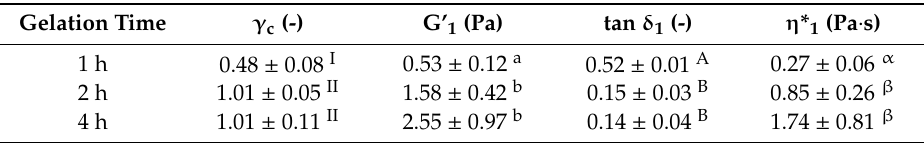
Table 1. G’, tan δ and η * at 1 Hz (G’ 1 , tan δ 1 and η * 1 ) and critical strain of the hydrogels as a function of the gelation time (1, 2 and 4 h).